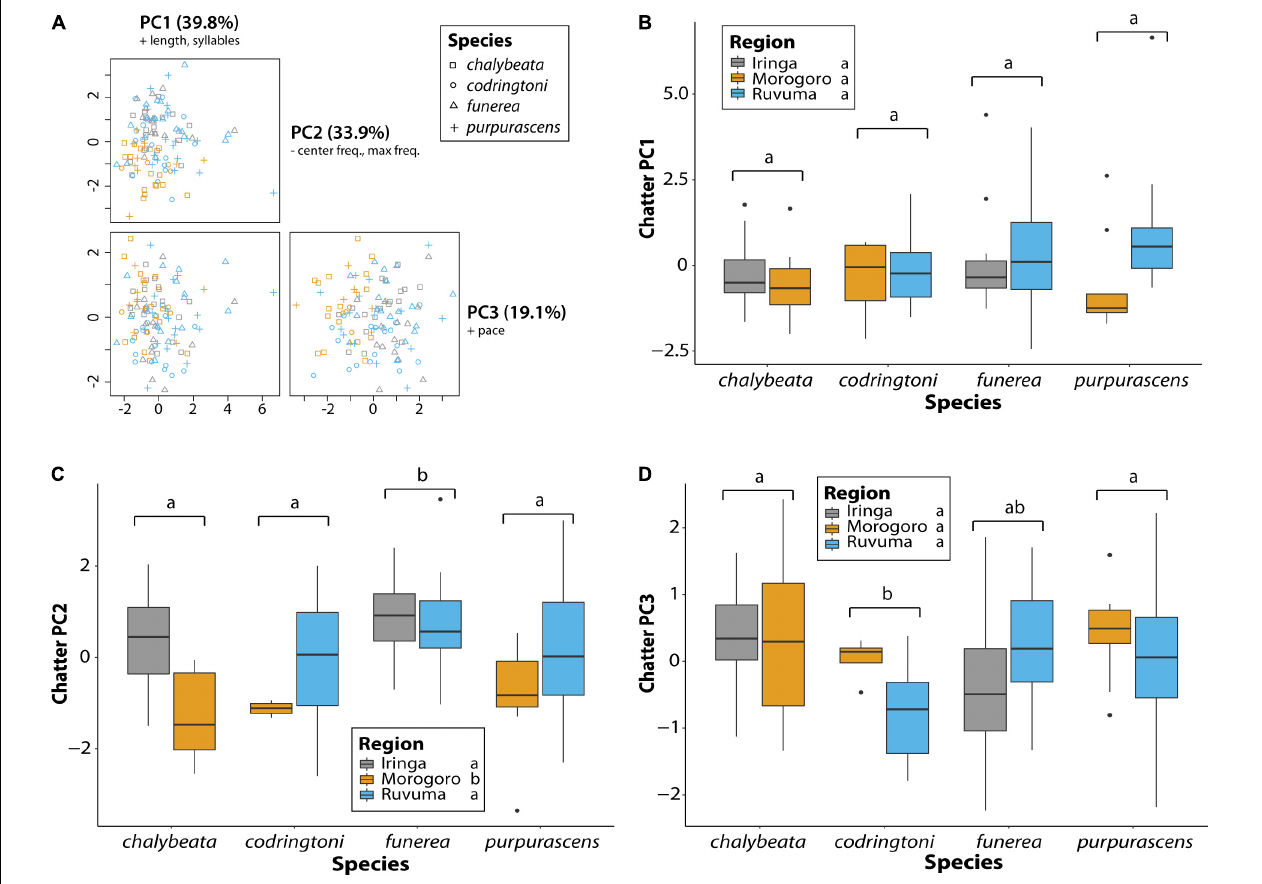
FIGURE 6 | Variation in chatter calls between indigobird species and sampled regions. Chatter length, number of syllables, pace, center frequency, and maximum frequency measurements were collapsed via a principal component analysis (A) . Variables with loadings > 0.4 (+) or < –0.4 (–) are indicated for each principal component. Variation among species and regions in the first three PC axes is shown in panels (B–D) . Significant differences between species (adjusted P < 0.05) are indicated by different lowercase letters above the brackets for each species. Similarly, regions labeled with different lowercase letters were significantly different in post hoc